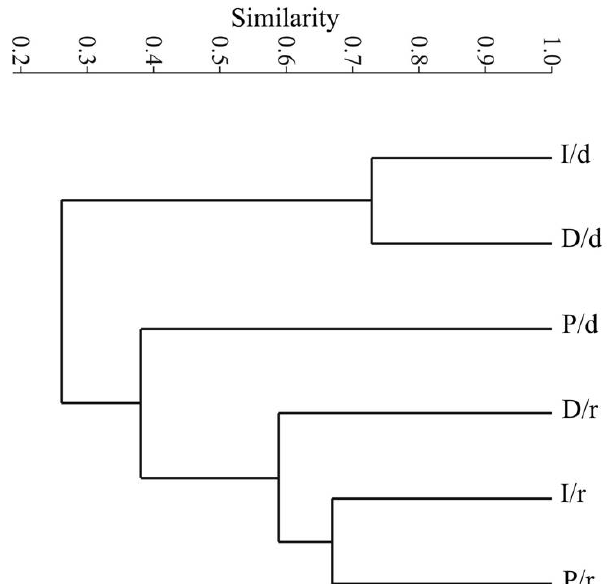
Fig 2. Similarity between areas/periods in function of the collected membracids in São José dos Cordeiros, Paraíba in 2006 (area: P, preserved; I, intermediate; D, degraded; period: r, rainy; d, dry).